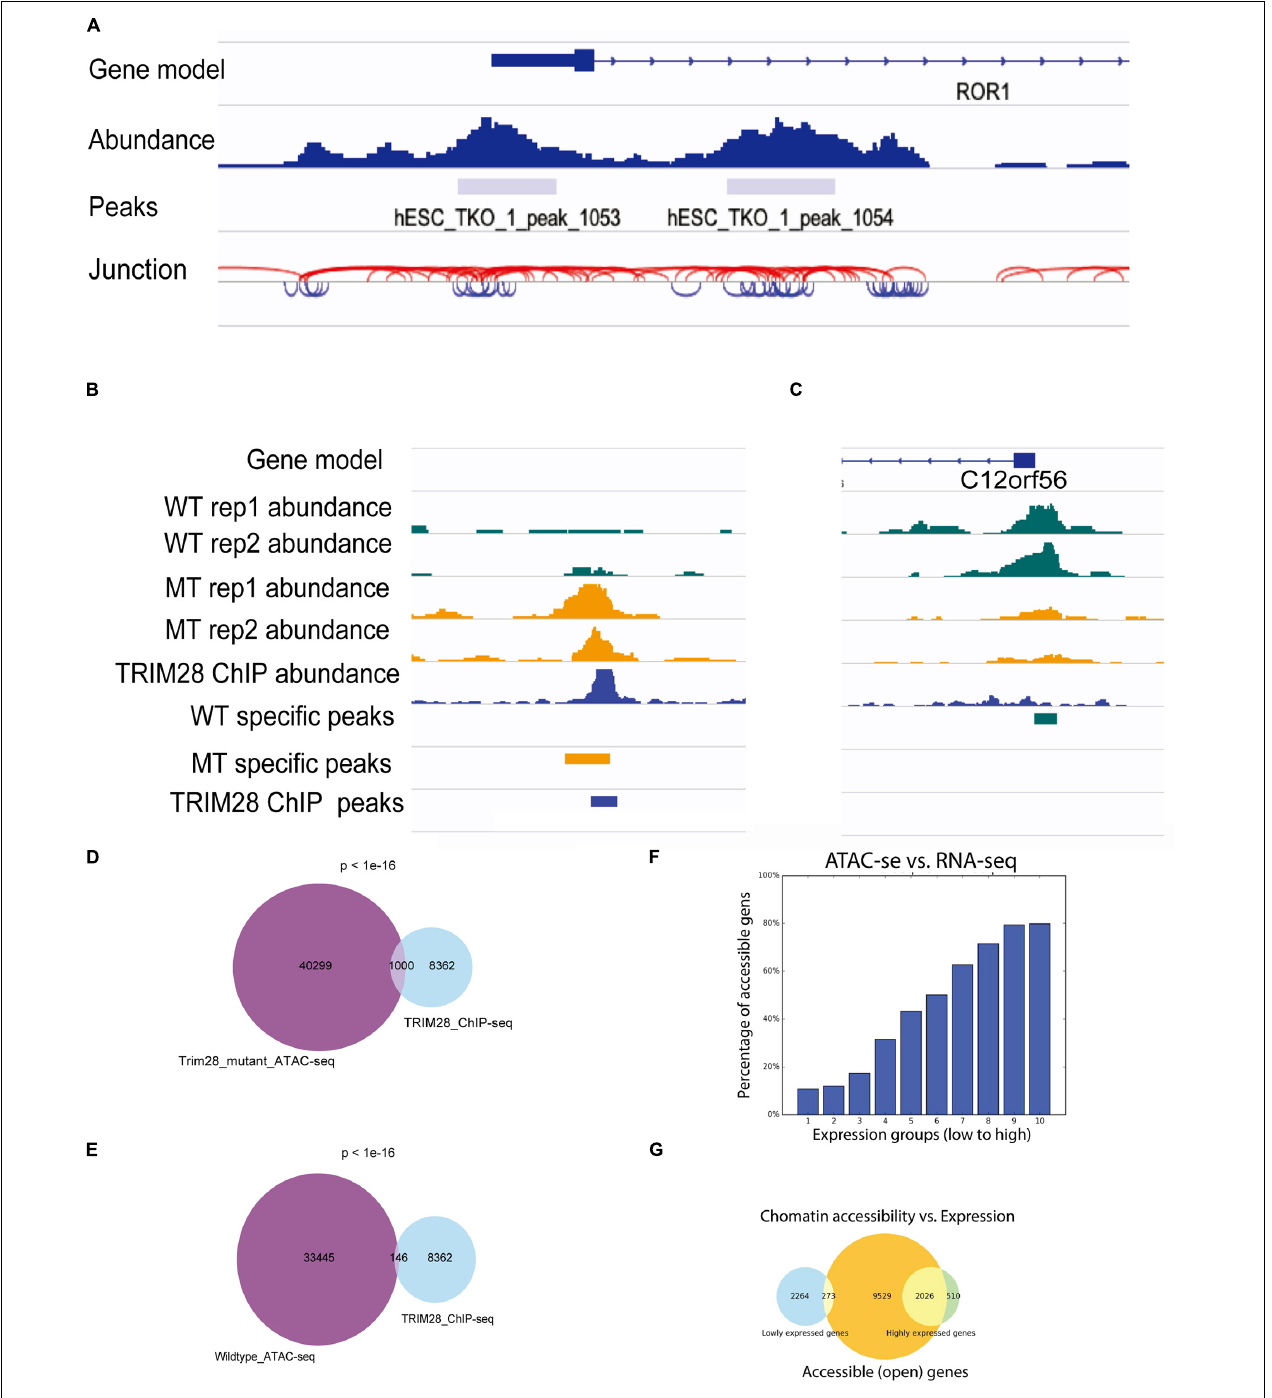
FIGURE 3 | Visualization of ATAC-seq tracks for the identification of accessible chromatin regions. (A) ATAC-seq abundance and peaks revealed the positions of accessible chromatin regions around a gene. ATAC fragment junction track shows long ( > 150 bp) and short ( < 150 bp) fragments with red and blue lines, respectively. The regions of blue lines suggest nucleosome-free regions, whereas the regions of red lines indicate nucleosome-occupied regions. (B,C) Human ATAC-seq data in wild-type (WT) and TRIM28 mutant (MT). TRIM28 Chip-seq track indicates the location of TRIM28 binding. The abundance tracks show differential abundance between MT and WT tracks at the binding site. (B) The region with more accessible in MT. (C) The region with less accessible in MT. (D) Venn diagram shows 1,000 peaks of overlap between TRIM28 mutant ATAC-seq peaks and TRIM28 ChIP-seq peaks. (E) Venn diagram only shows 146 overlapping peaks between wild-type ATAC-seq without TRIM28 ChIP-seq peaks. (F) The bar plot shows that highly expressed genes tend to have a higher percentage of accessible genes than lowly expressed genes. (G) The Venn diagram shows the overlapping genes between accessible regions and highly/lowly expression genes.